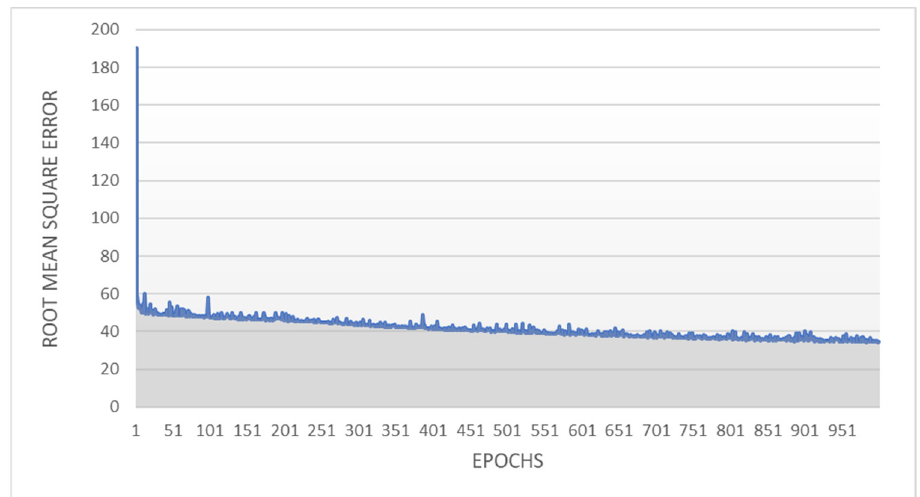
Figure 4. Root Mean Squared Error to Epochs for the Lower-level Psychopathology Artificial Neural Network Model. Note. Depiction of the accuracy and learning rate of the higher-level psychopathol- ogy artificial neural network model used in this research. The grey area under the blue line represents the summed squared error of the model that after particular number of epochs.